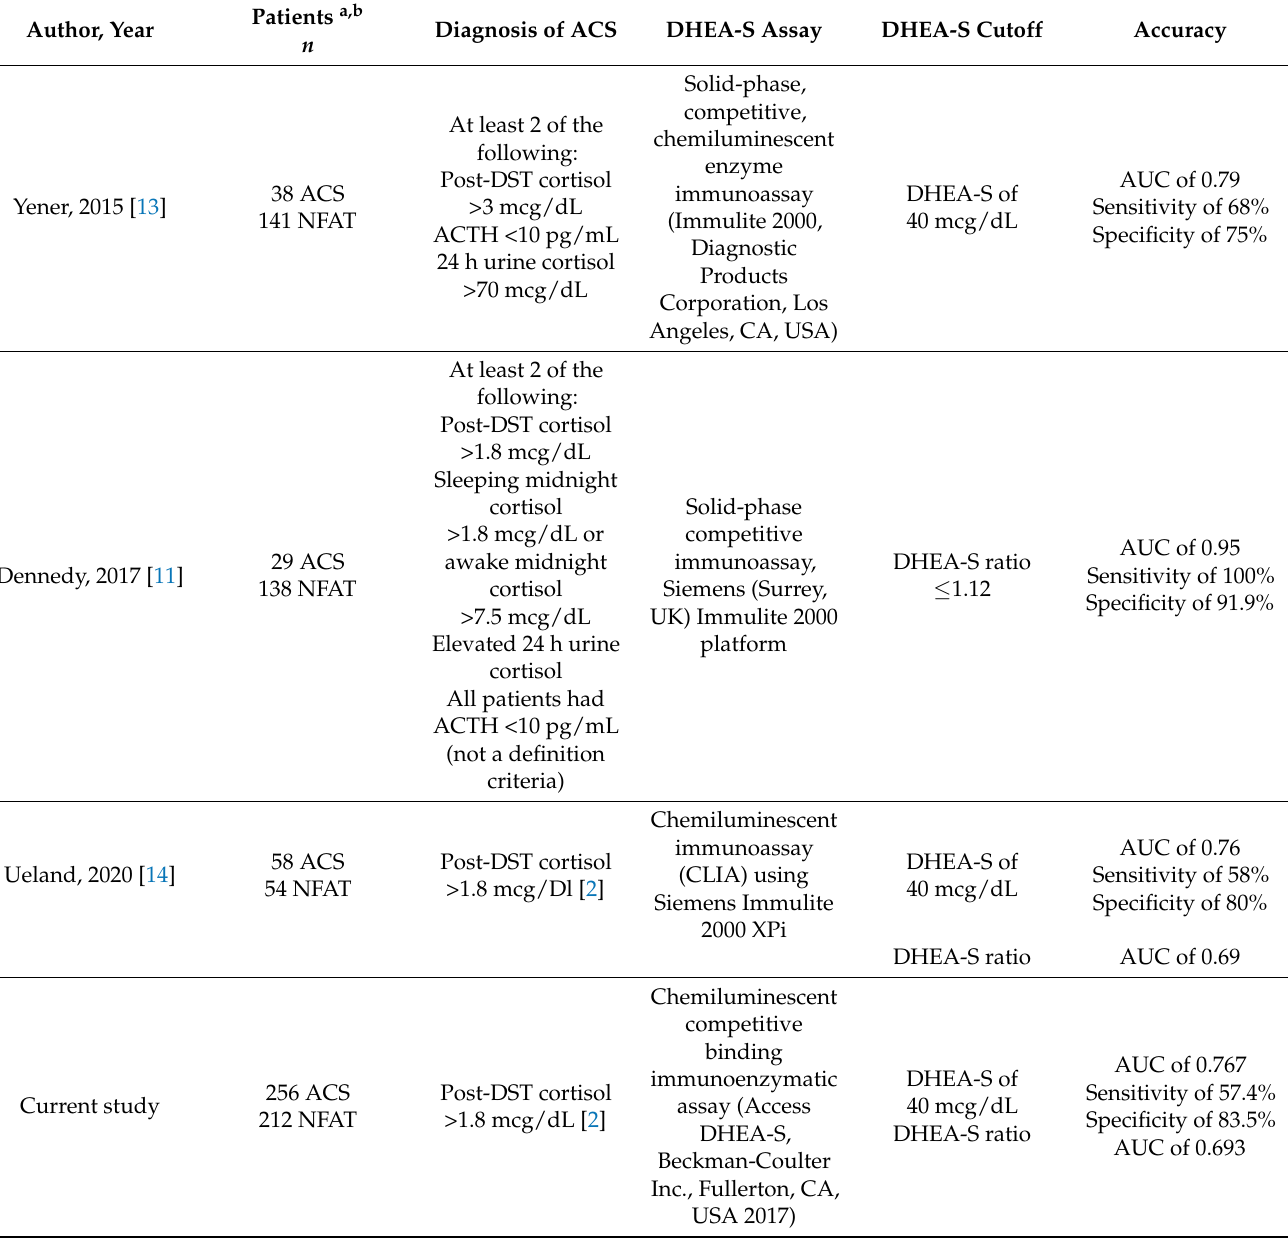
Table 3. Studies investigating accuracy of DHEA-S in diagnosing autonomous cortisol secretion (ACS) a